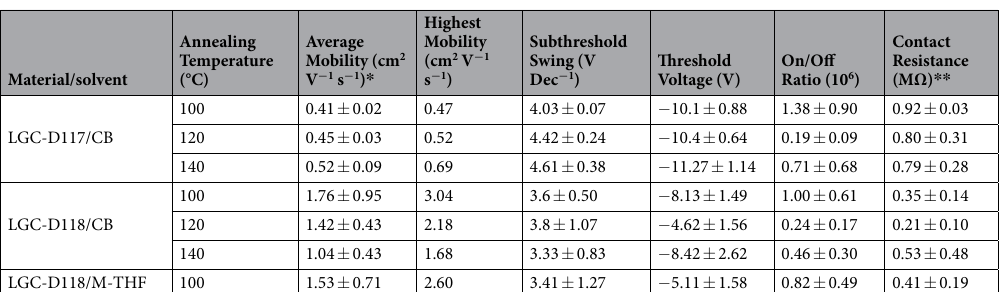
Table 2. Summary of devices incorporating different materials and annealing conditions. * Error in average mobility = standard deviation ( σ ) of values. Averaging was performed for 4–8 devices. ** Contact resistance at channel width of 1000 µ m obtained using the Y-function method 52